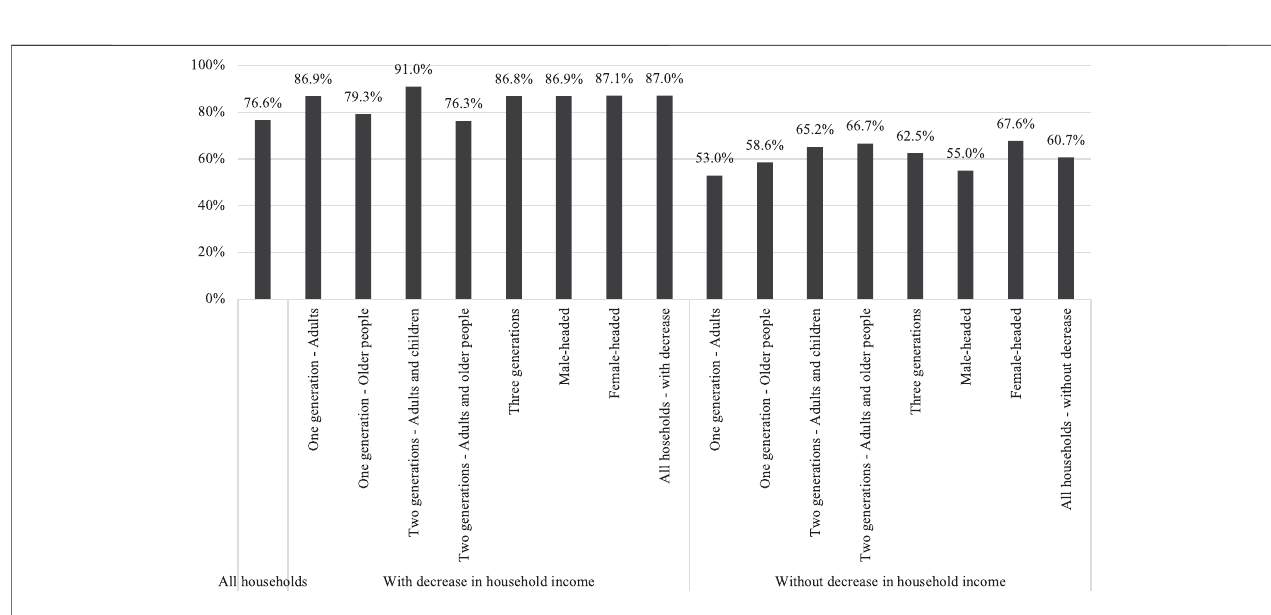
FIGURE 5 | Households reporting having adopted at least one expenditure-minimising strategy by household composition and headship. Notes: Sample weights applied. All differences by income-generating strategies and household composition or household headship are signi fi cant at p < 0.001, except by differences by income-generating strategies and household headship among households with decrease in household income, which are signi fi cant at p < 0.01.